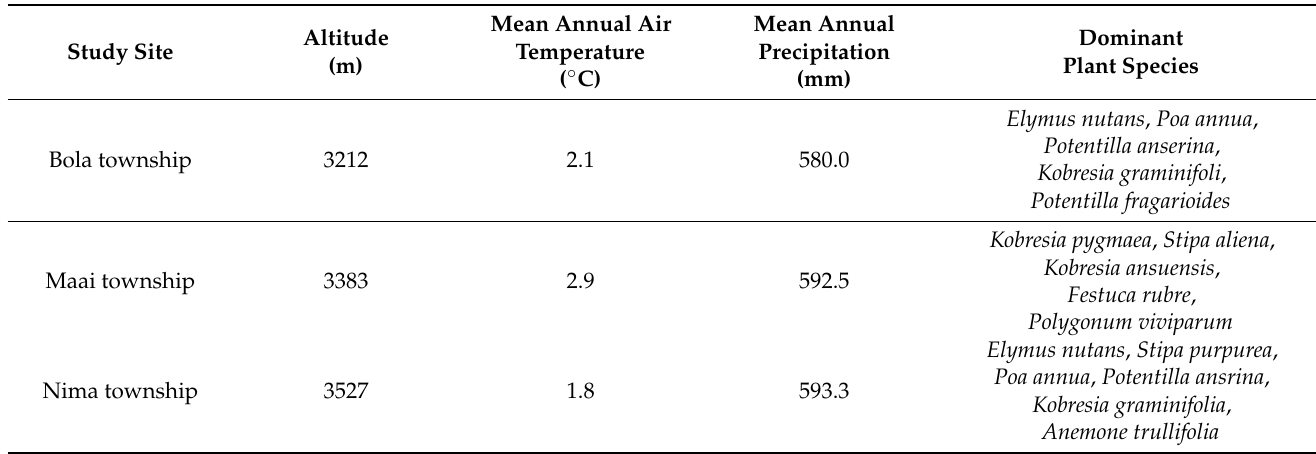
Figure 1. Location of the study area and sites in China. Table 1. Information regarding the study